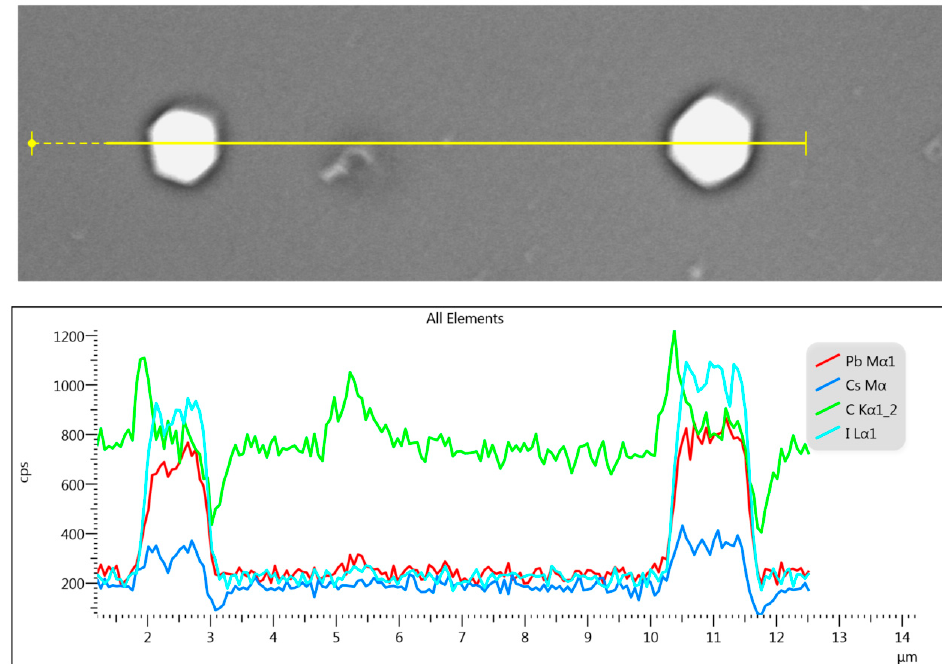
Figure 7. Energy dispersive X-ray spectroscope (EDS) analysis for surface-passivated sample.